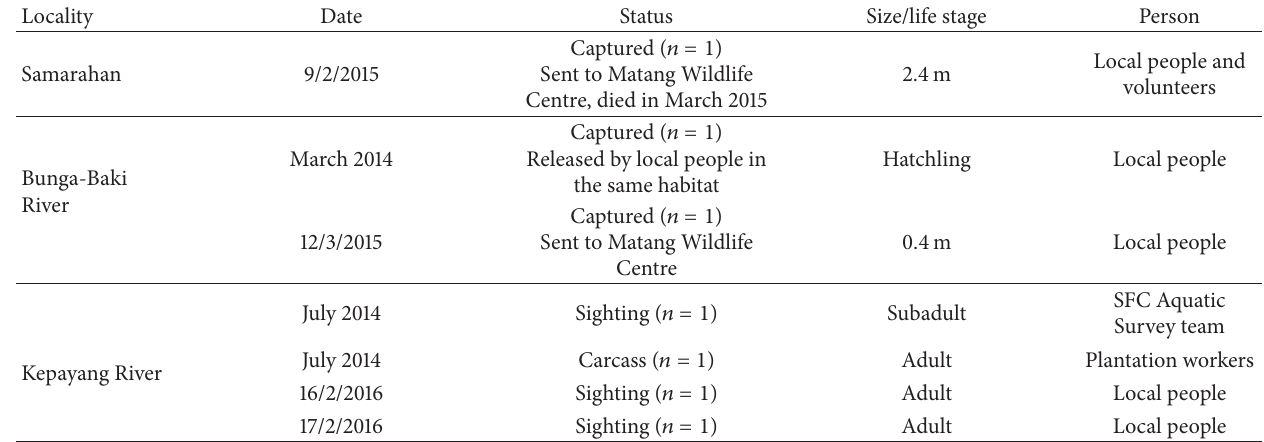
Table 2: History of Tomistoma sightings or captured Tomistoma (2014–2016).